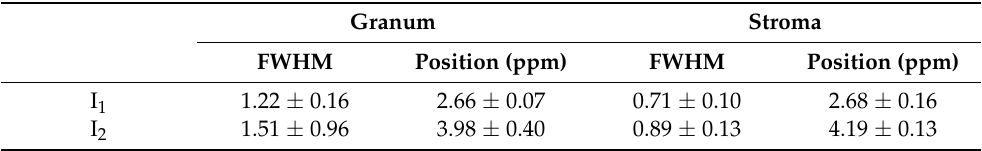
Table 1. Position and half-bandwidth of the two isotropic peaks of the granum and stroma thylakoid membranes, as derived from the mathematical deconvolution of the 31 P-NMR spectra recorded at 5 ◦ C. Errors represent standard deviation from 10 experiments of 3